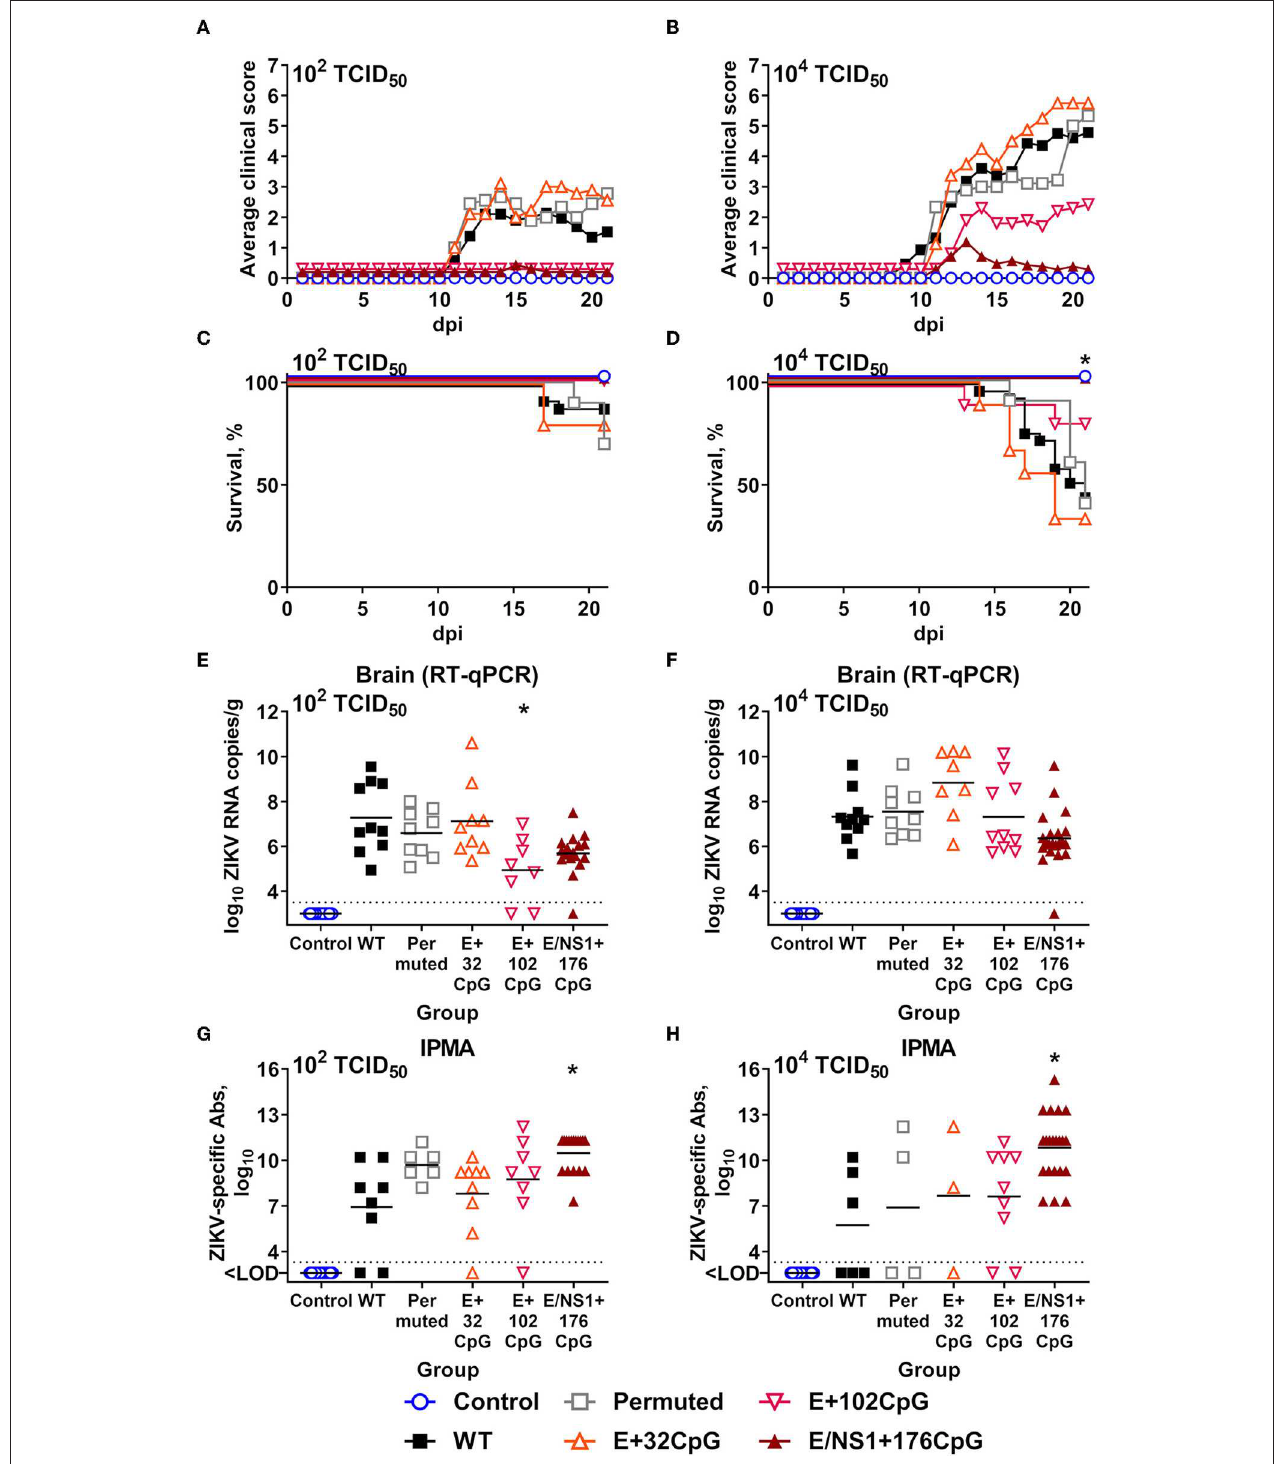
FIGURE 6 | Infection phenotypes of ZIKV variants in neonatal mice. One-day-old pups (control: n = 19; ZIKV variants: n = 8–29) were inoculated with either 10 2 or 10 4 TCID 50 of ZIKV. (A,B) Mean clinical scores: 0—no visible abnormalities; 1—mild ataxia and/or tremors; 2—obvious ataxia and/or tremors; 3—depression, hunching, reluctance to walk, and falling to the side when walking; 4—obvious hyperactivity; 5—close to moribund but still somewhat responsive; 6—paralysis; 7—death. (C,D) Percentage of survival. (E,F) ZIKV loads in brains sampled at 21 days after inoculation or death. (G,H) ZIKV-specific IgG Ab titers in blood plasma at 21 days after inoculation; quantified by immunoperoxidase monolayer assay—IPMA. Asterisk (*) denotes statistically significant difference compared to the WT ZIKV group. Dotted lines represent the LOD, solid lines represent mean